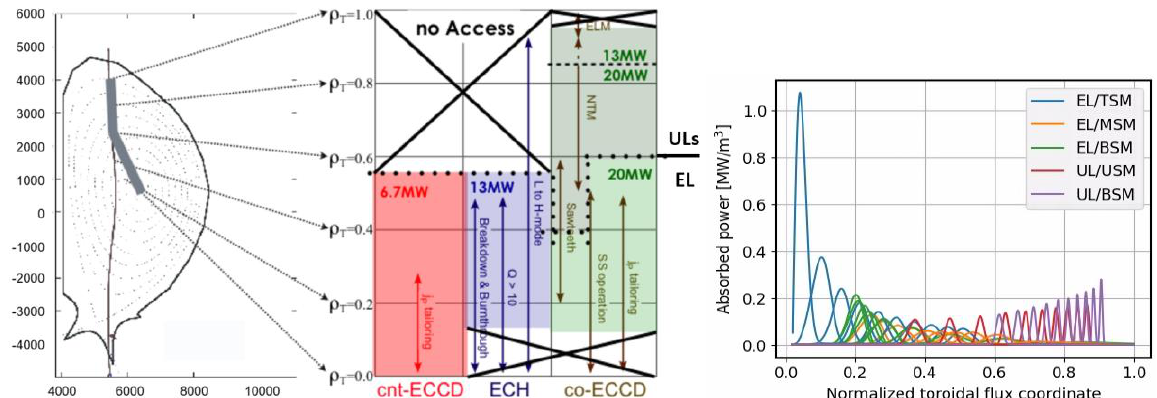
Fig. 2. Left: deposition access of the EL and ULs across the plasma cross section and categorized based on driving counter (cnt) ECCD (shaded red), co-ECCD (shaded green) or pure heating (shaded blue), considering 1MW gyrotrons. Right: radial coverage of EC system when steering the poloidal angle for each mirror of the EL and ULs, as simulated with the TORBEAM wave code [3].